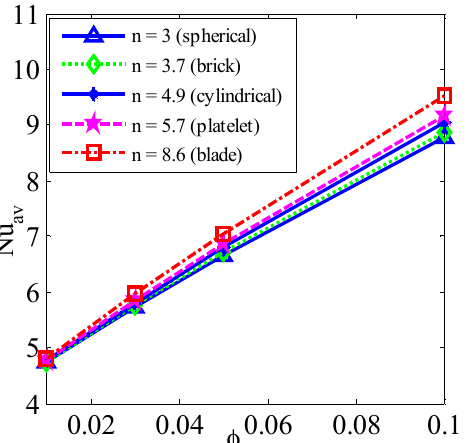
Figure 13. Average Nusselt number ( Nu av ) for different nanoparticles diameter ( d ) and nanoparticles volume fraction ( ϕ ) when Ra = 10 6 , Ha = 30, λ = 0.5, d = 10 nm, n = 3, and τ = 1.